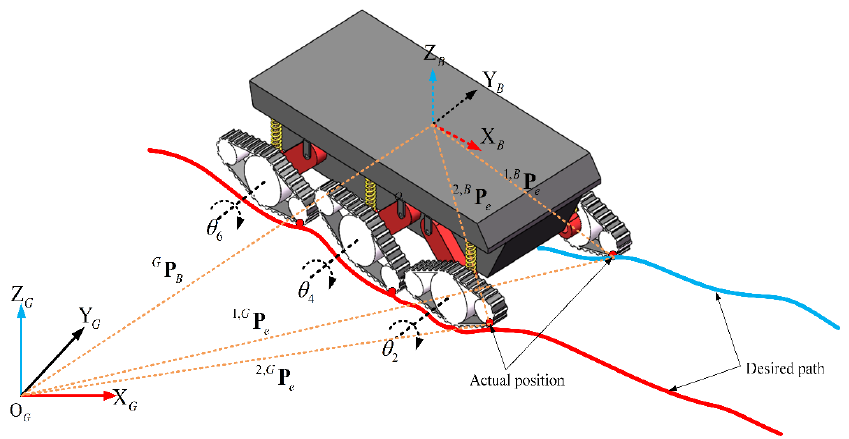
Figure 4. Differential kinematics of a six-track robot.